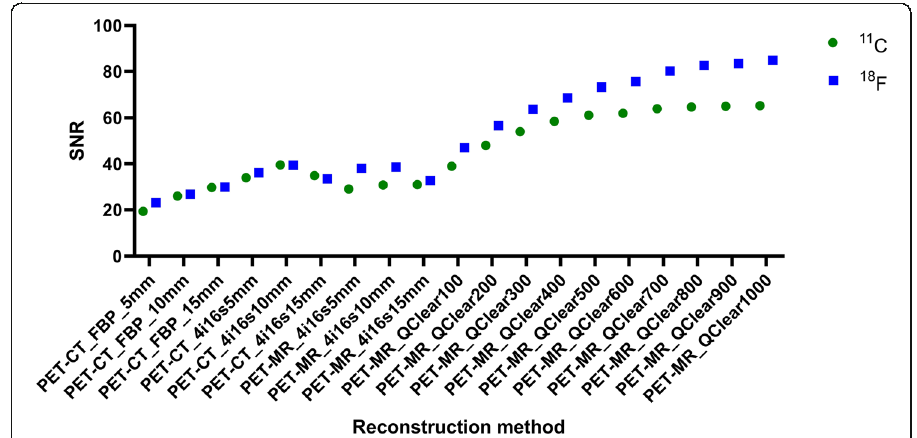
Fig. 7 Hoffman phantom measured signal-to-noise for all reconstruction methods when using a 11 C and a 18 F-solution. Note the best signal-to-noise was obtained with Q.Clear with β